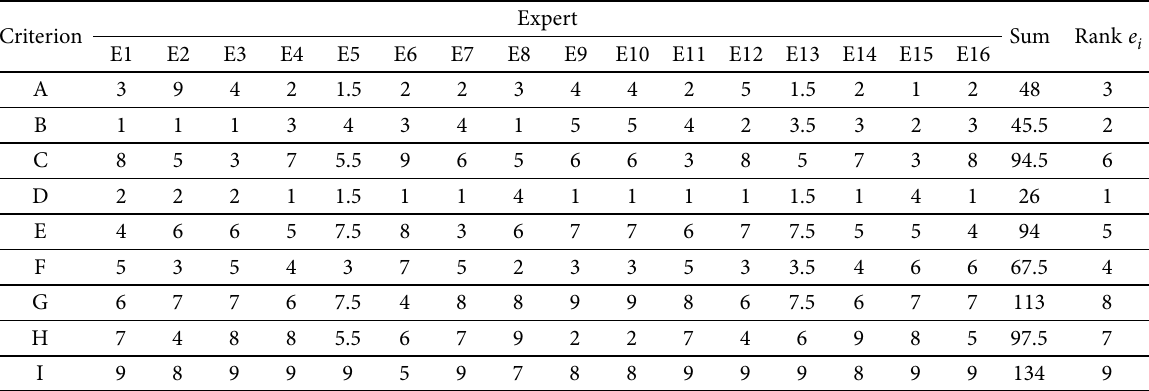
Table 6. The ranks of criteria e ik assigned by the experts